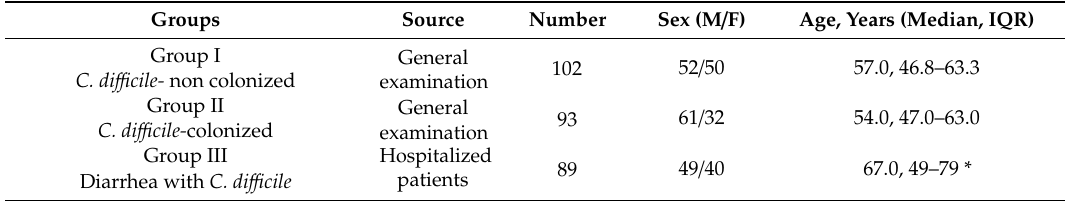
Table 1. Demographic information for the subject in each